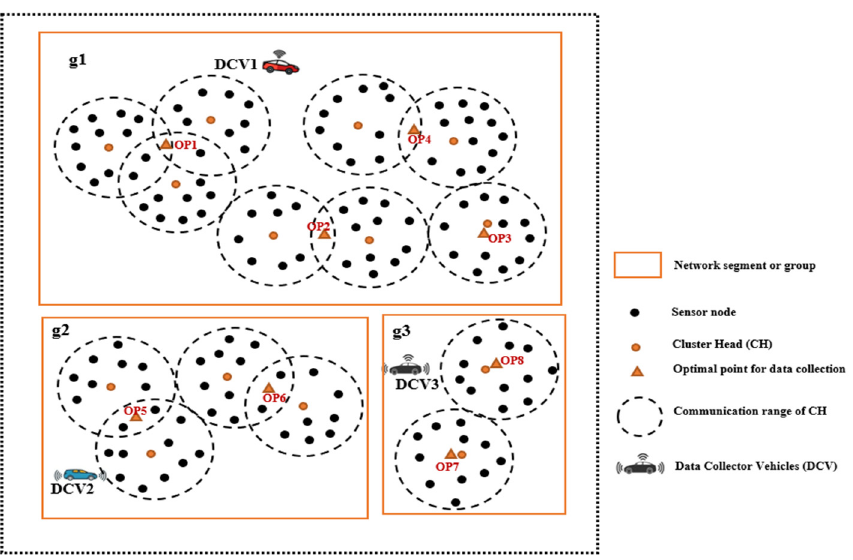
Figure 4. Network model and components for LS-WSN.